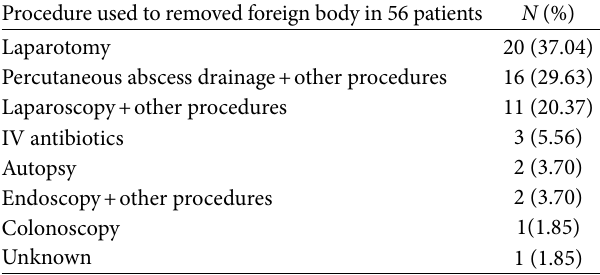
Table 3: Procedures used to remove fishbones (reference from Table